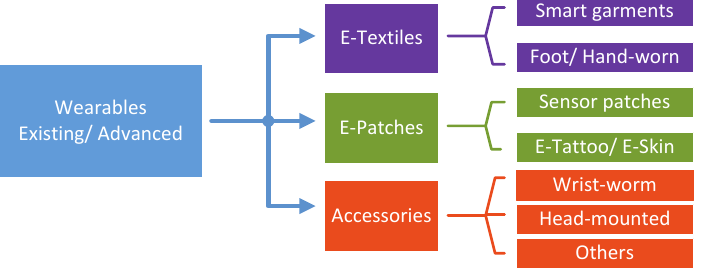
Figure 1. Main categories of existing wearable